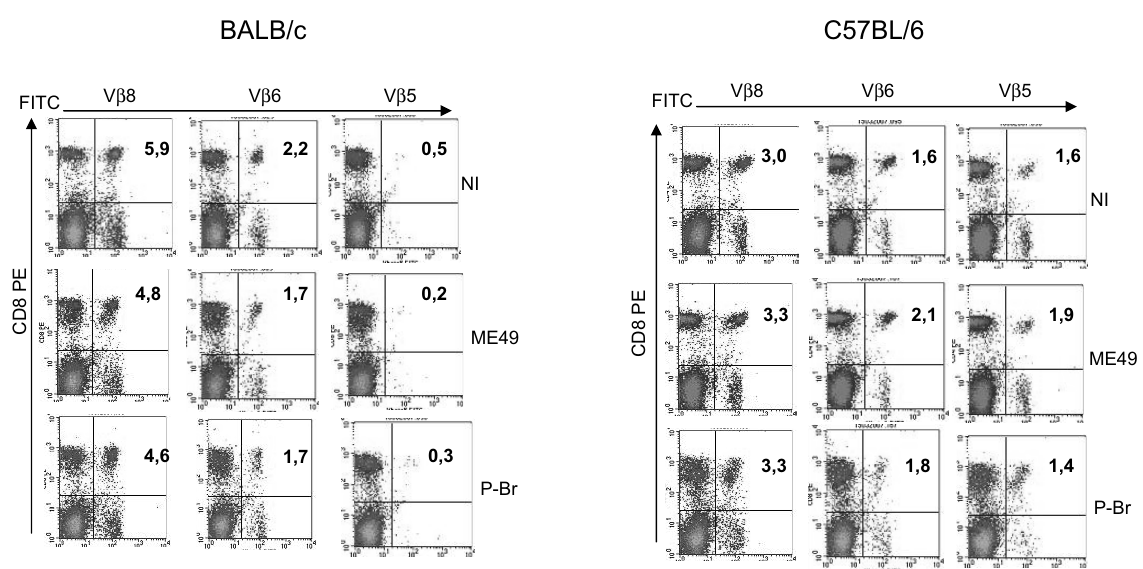
Fig. 3 – Frequency of different TCR V β chains in CD8+ T cells from animals infected with T. gondii . Splenocytes were obtained 2-4 weeks after oral infection with tissue cysts. Cells were double-stained with monoclonal antibodies specific for CD8 + molecule and different V β chains. NI, non-infected mice. Results of one representative experiment. Experiments were repeated independently four